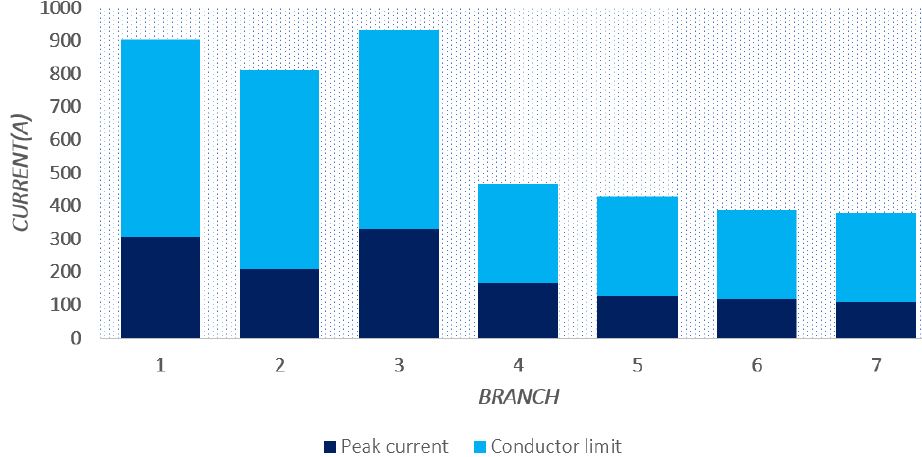
Figure 6. Behavior of the current in the branches for the IEEE system of 8 buses (unbalanced).